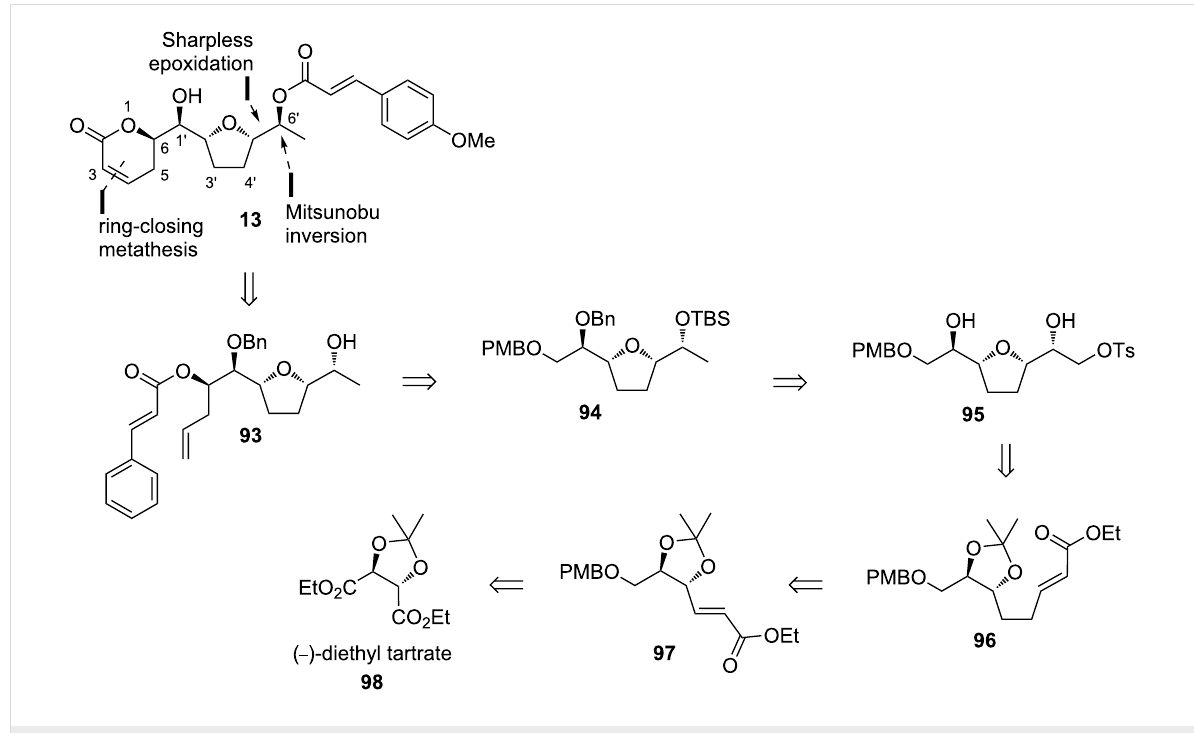
Scheme 11: Retrosynthetic analysis of brevipolide M ( 13 ) by